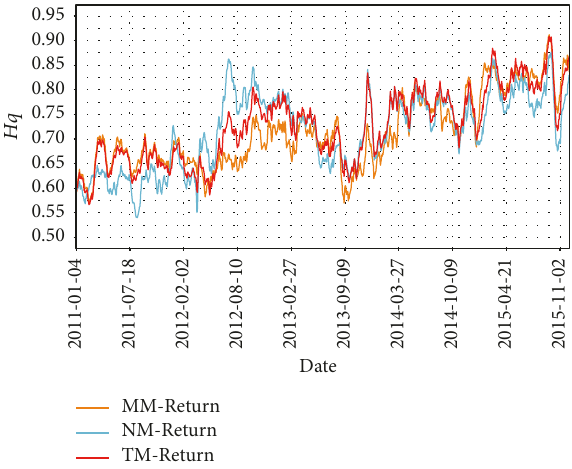
Figure 12: Time varying scaling exponents for 𝑞 = 2 for news and